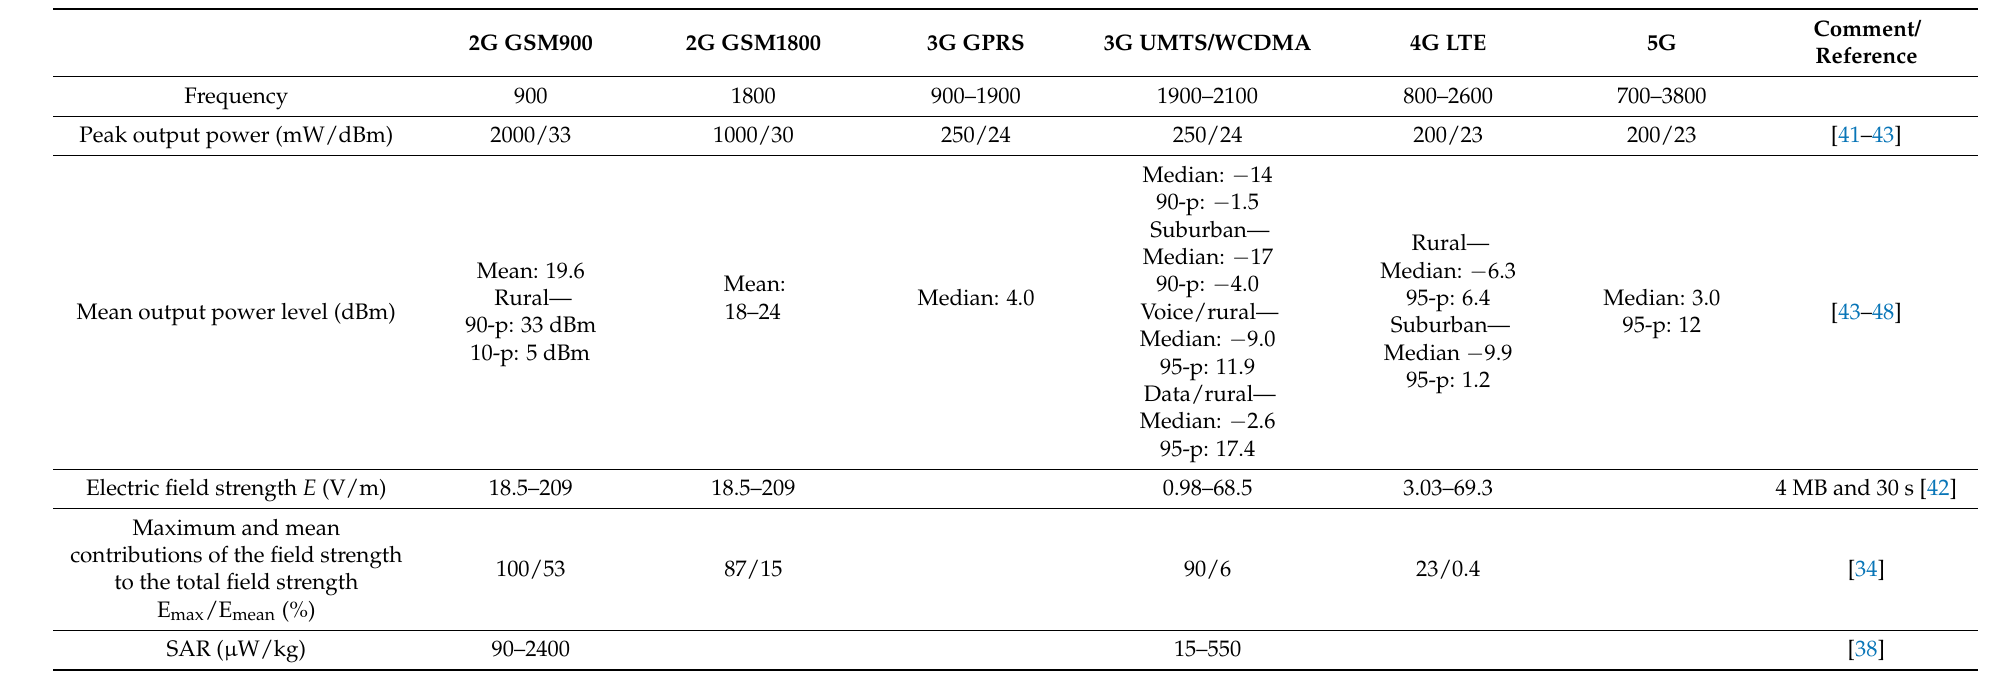
Table 7. Characteristics of handheld devices (HHDs) for various transfer protocols (2G to 5G) and types of data